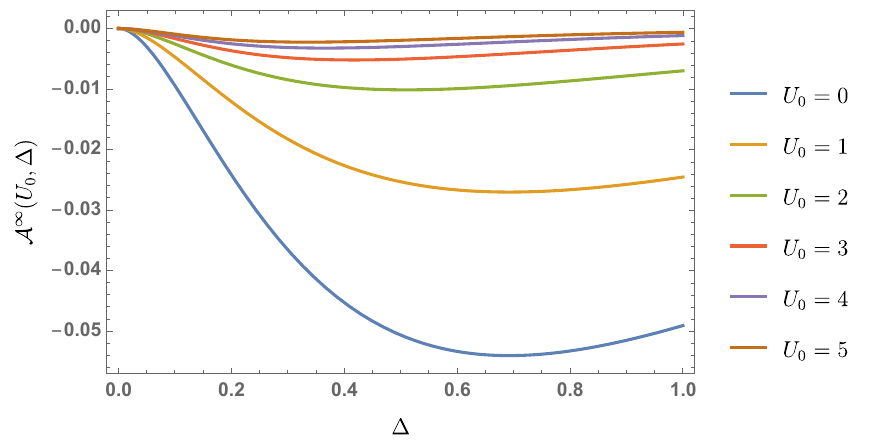
Figure 2. Dimensionless Averaged Null Energy as a function of (cid:1). The curves correspond to di(cid:11)erent starting time U 0 , while the end point is always U f = + 1 . The earlier we turn on the interaction the more negative energy we can obtain (note that U 0 = 0 corresponds to boundary time t = (cid:0)1 and U 0 = 1 to t =